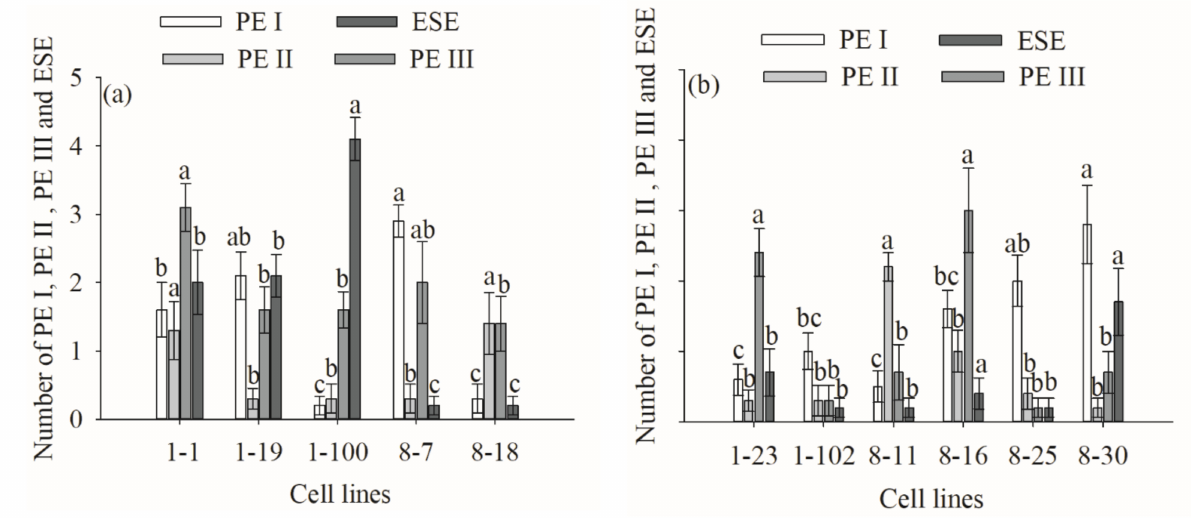
Figure 7. Differences in the number of ESEs between different cell lines of P. koraiensis . ( a ) R cell lines; ( b ) B cell lines. Different letters above the column indicate significant differences at the p < 0.05 level. 2.4. Differences in Soluble Protein, Soluble Sugar, and Starch Contents between Different Cell Lines of P.